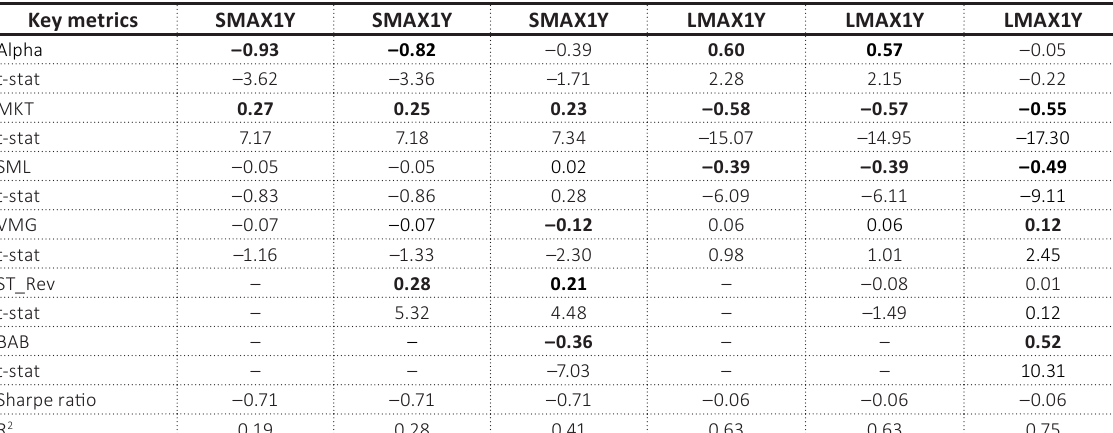
Table B1. LMAX and SMAX based on yearly look-back periods, namely LMAX1Y and SMAX1Y